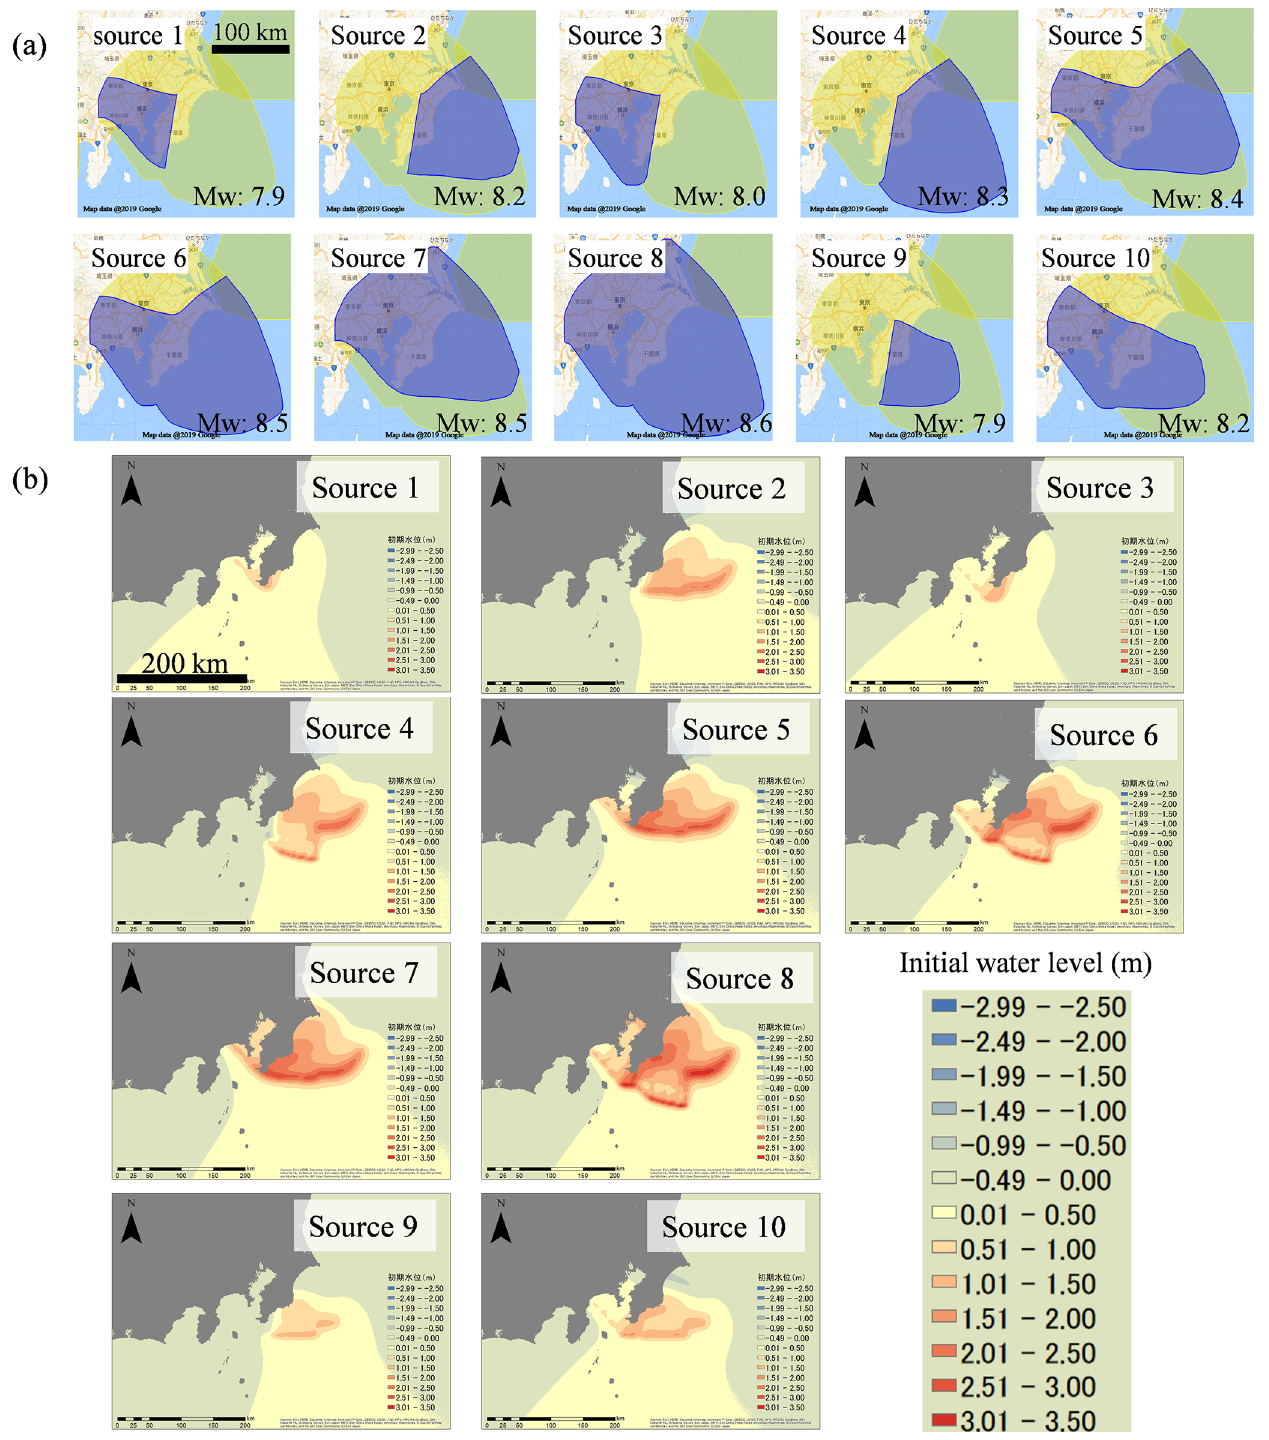
Figure 4. (a) The 10 sources of the Sagami Trough earthquakes (NIED, 2017) and (b) initial water levels of the tsunami calculated from the fault parameters using the Okada equation (Okada, 1985). © OpenStreetMap contributors 2019. Distributed under a Creative Commons BY-SA